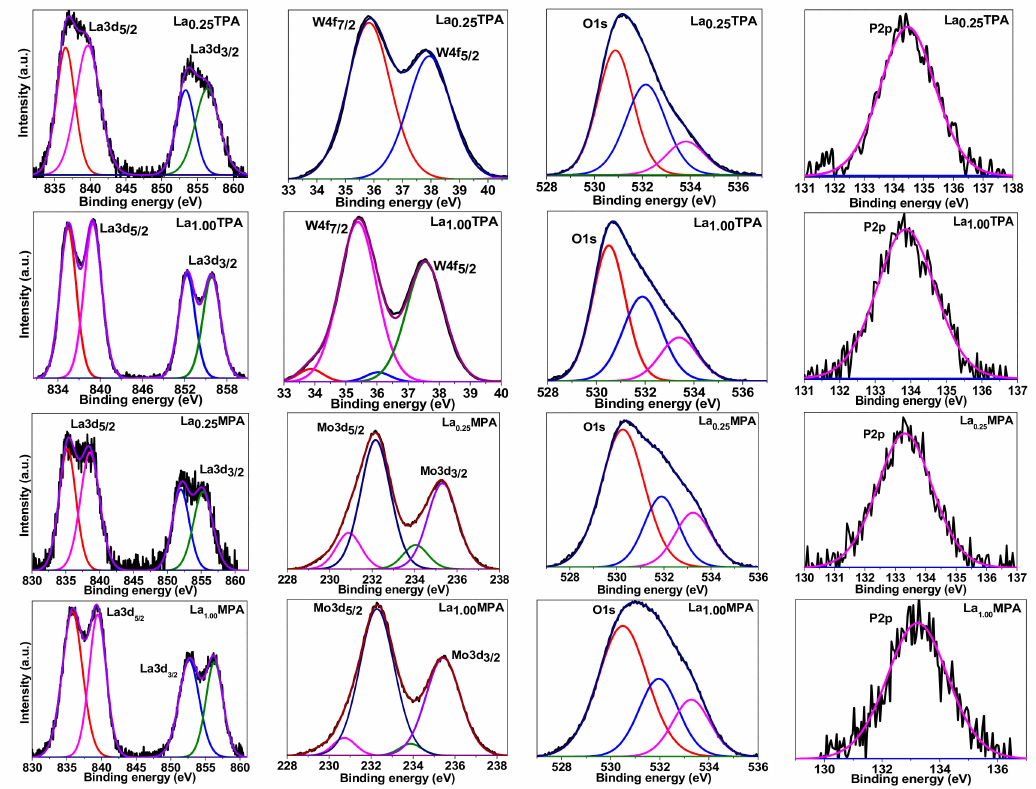
Figure 4. Deconvoluted X-ray photoelectron spectra for La 0.25 TPA, La 1.00 TPA, La 0.25 MPA, and La 1.00 MPA